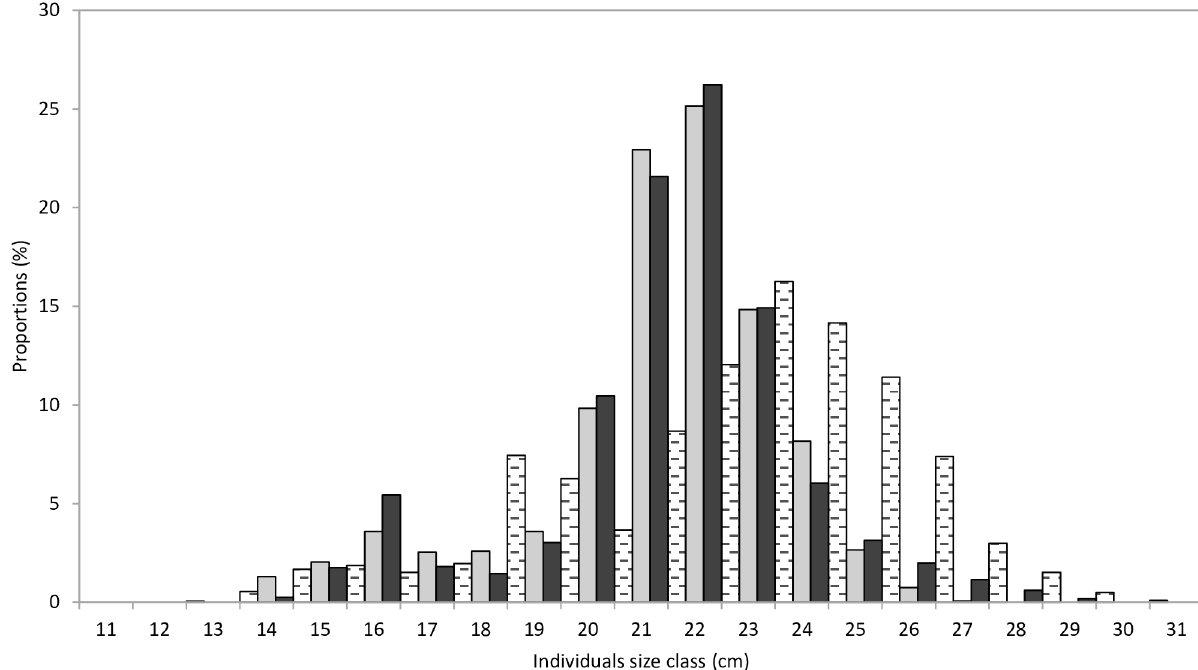
Fig 4. Sardinella maderensis size spectra for Kayar (dashed horizontal), Mbour (black), and Joal (grey). Sizes are represented by the fork length.